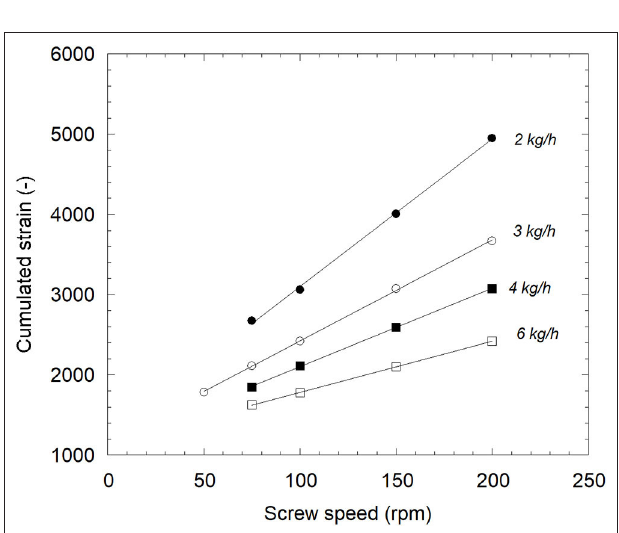
FIGURE 5 | Changes in cumulated strain with screw speed for different feed rates.